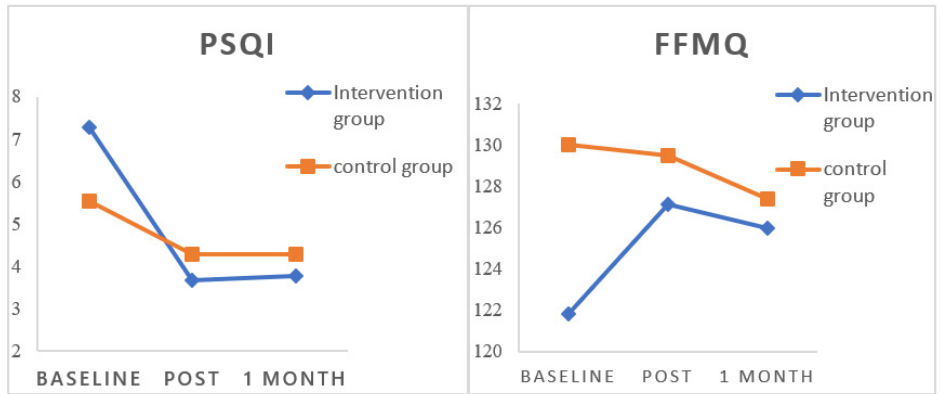
Figure 2. Overall PSQI and FFMQ scores in the two groups over time. Note. PSQI: Pittsburgh Sleep Quality Index; FFMQ: The Five Facet Mindfulness Questionnaire; n = 45.